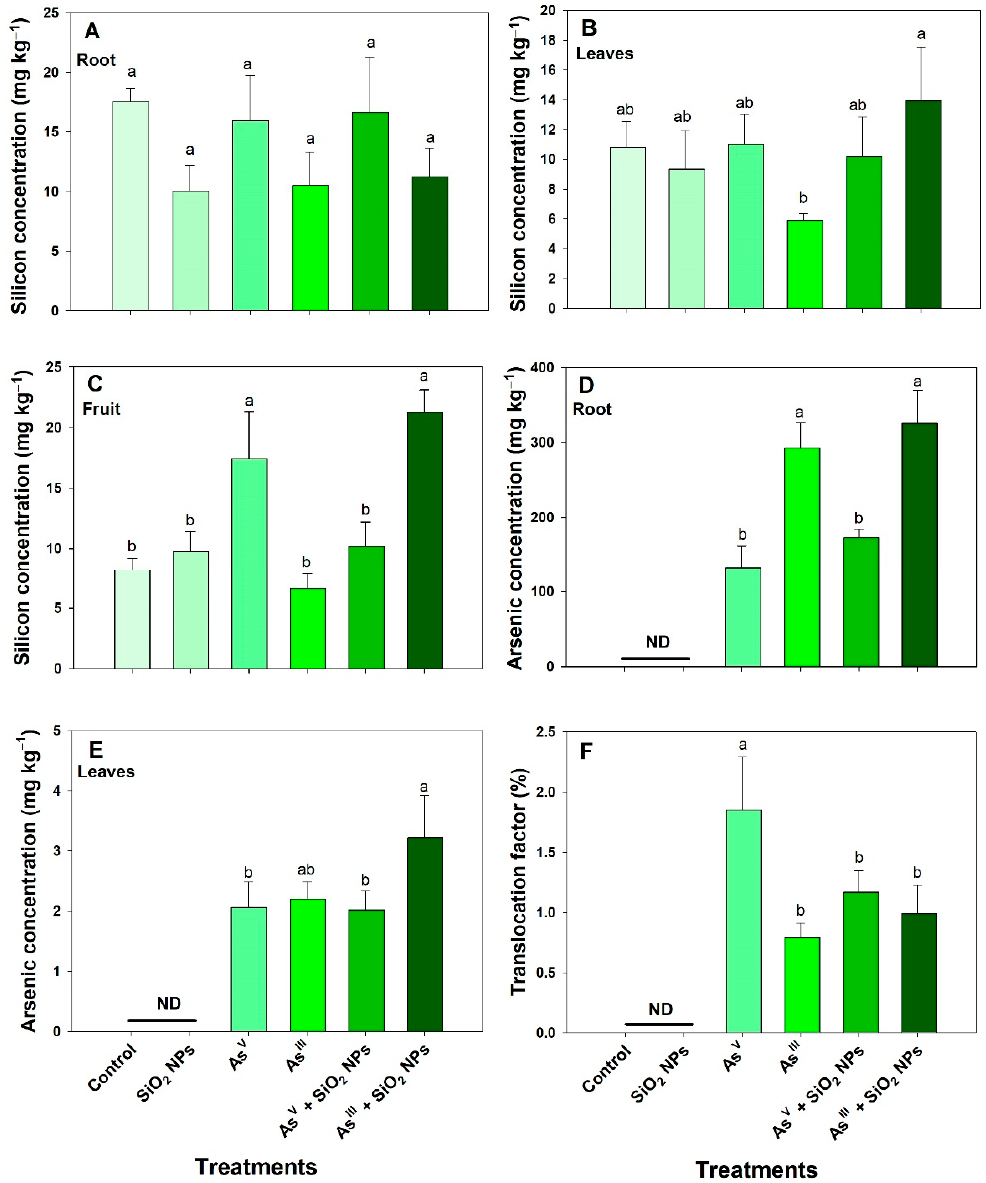
Figure 2. Silicon concentration in ( A ) roots, ( B ) leaves, and ( C ) fruits. Arsenic concentration in ( D ) roots, ( E ) leaves, and ( F ) arsenic translocation factor. Plants treated with 3.2 mg L − 1 of As V (Na 2 HAsO 4 ∙ 7H 2 O) and As III (NaAsO 2 ) via irrigation through the nutrient solution and 1000 mg L − 1 of SiO 2 NPs via substrate. ND: no detected. Lower-case letters different per bar indicate statistical differences according to the Fisher ′ s least significant difference test ( p ≤ 0.05). n = 5 ± standard error.